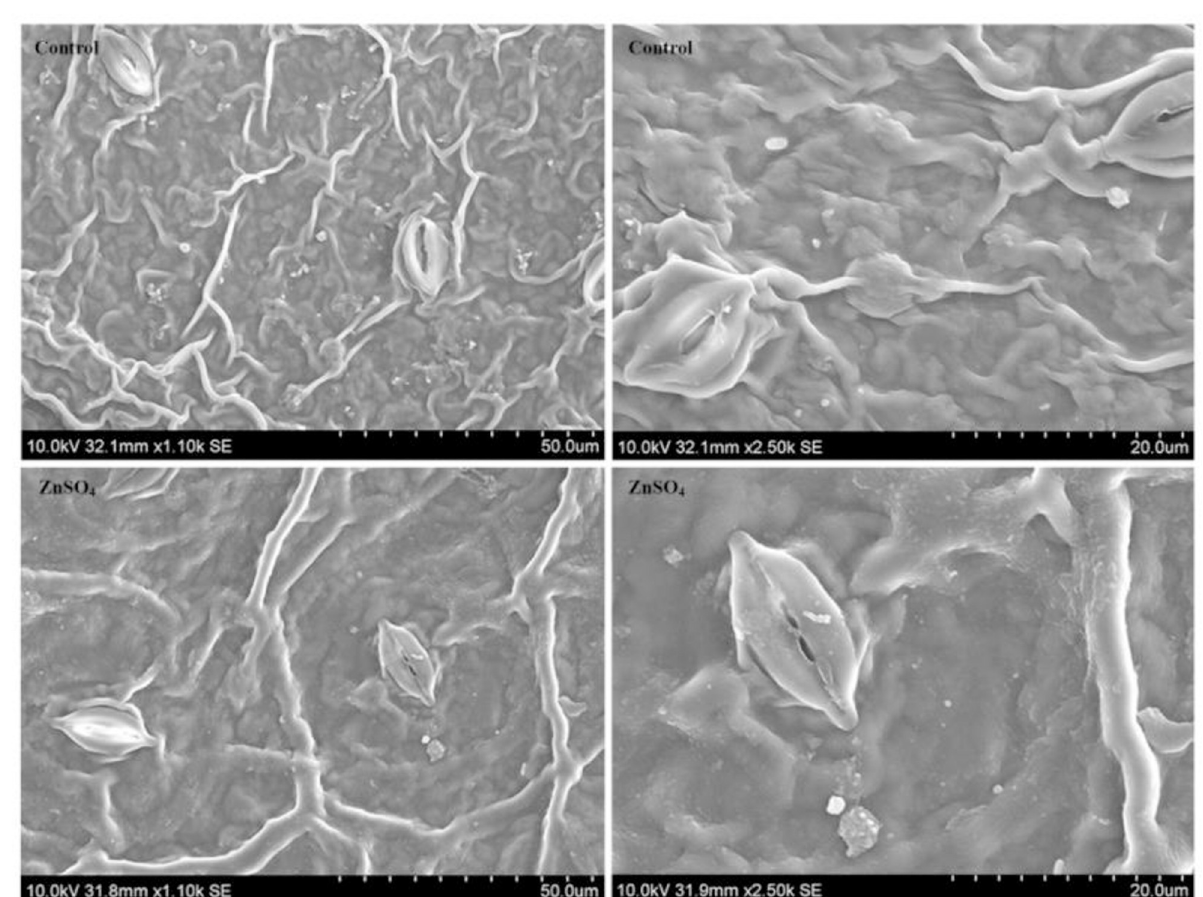
Fig 7. Scanning electron micrograph of stomata in the leaves of A . ilicifolius (control and ZnSO4 treated).